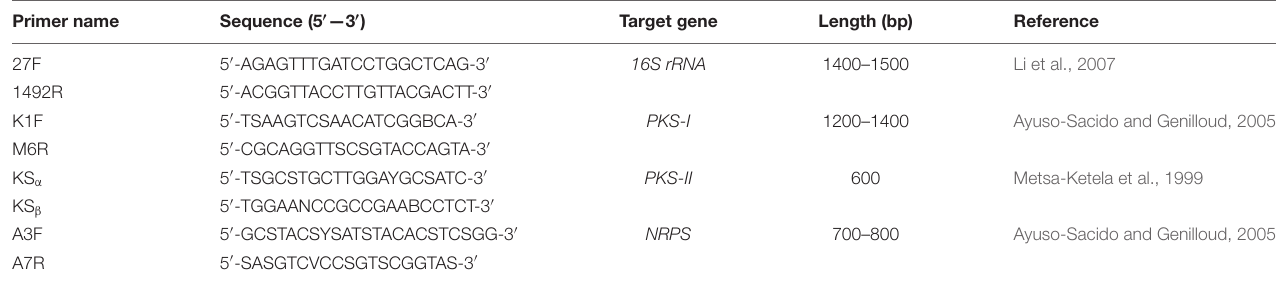
TABLE 2 | Polymerase chain reaction (PCR) primers used in this